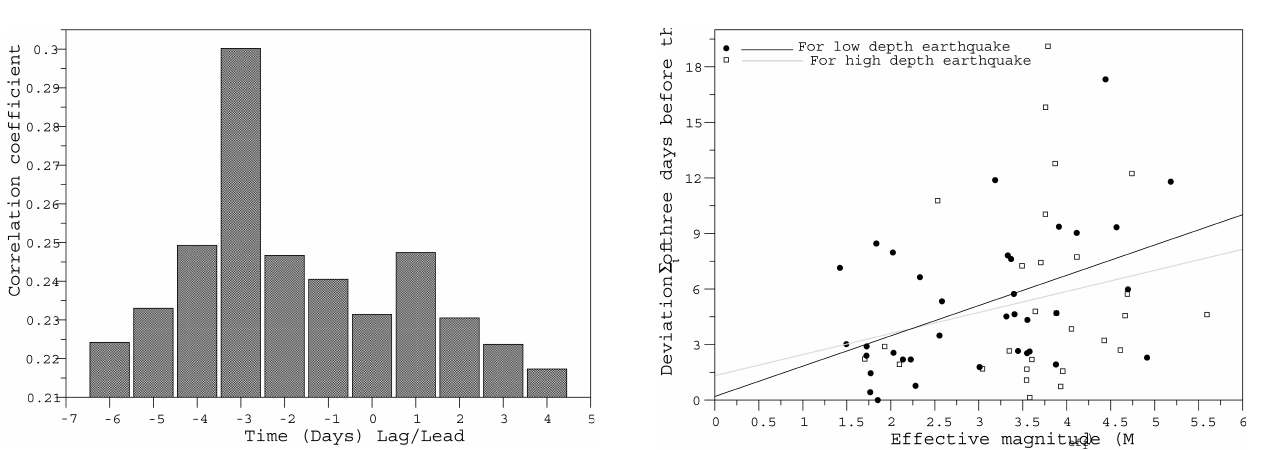
Fig. 4. Correlation between the effective magnitude M eff earthquake at the middle point between the transmitter and the re- ceiver, and the deviation of the fluctuation measure 6 i . Note that the correlation peaks three days before the event days.